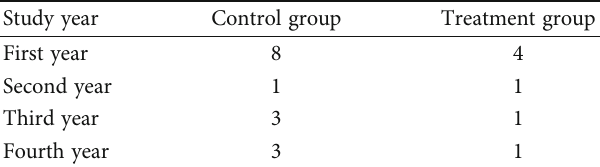
Table 2: Distribution by year.